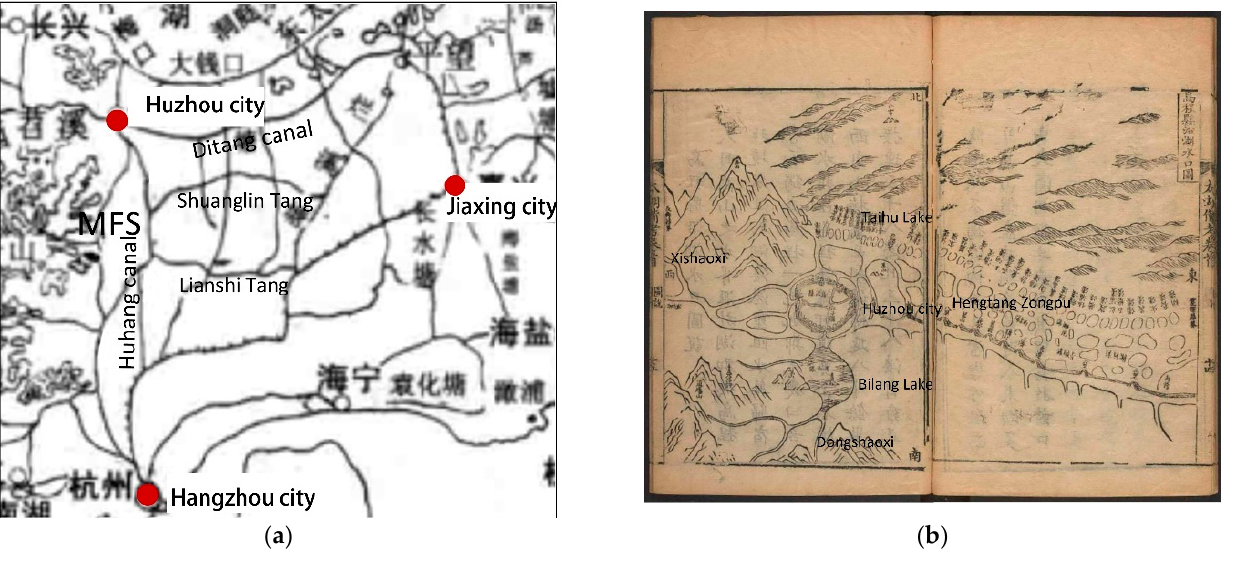
Figure 2. Map of the canal system of Huzhou area for the year 1987 [36] ( a ) and map of regional water system of Gui’an county (Huzhou city) (1750–1795) [37] ( b ). water system of Gui’an county (Huzhou city) (1750–1795) [37] ( b